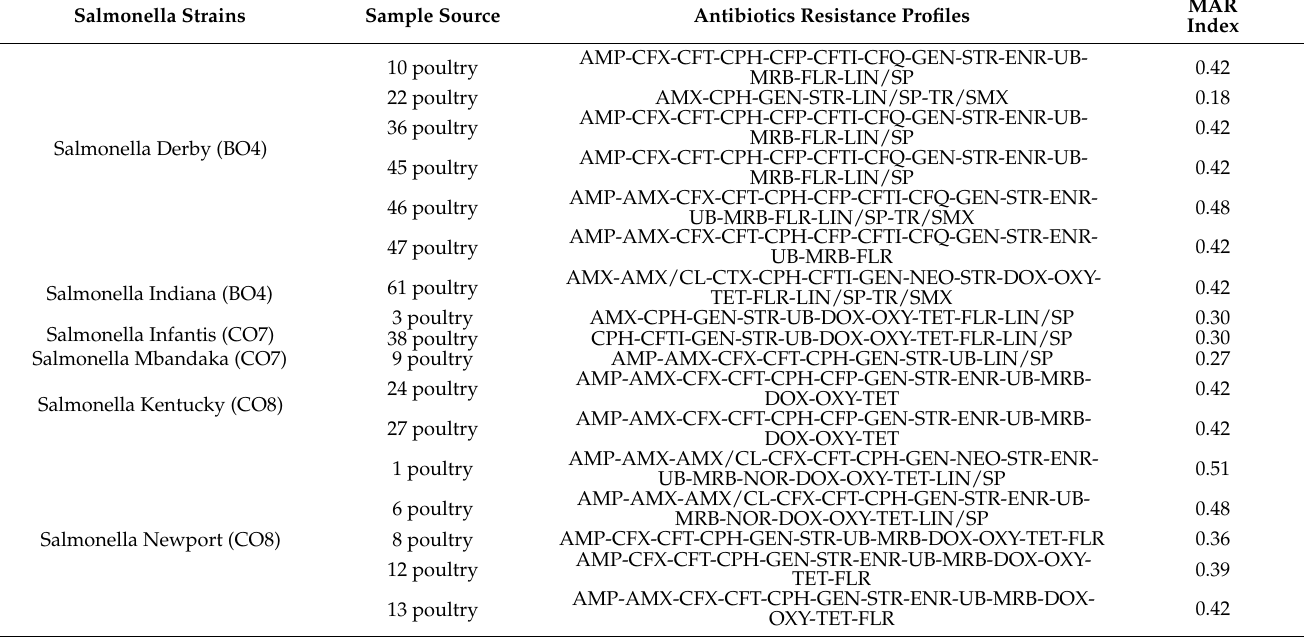
Table 2. Multiple Antibiotic Resistance Index and phenotype pattern of Salmonella enterica spp. enterica all identified serovars isolates from meat samples of pork and